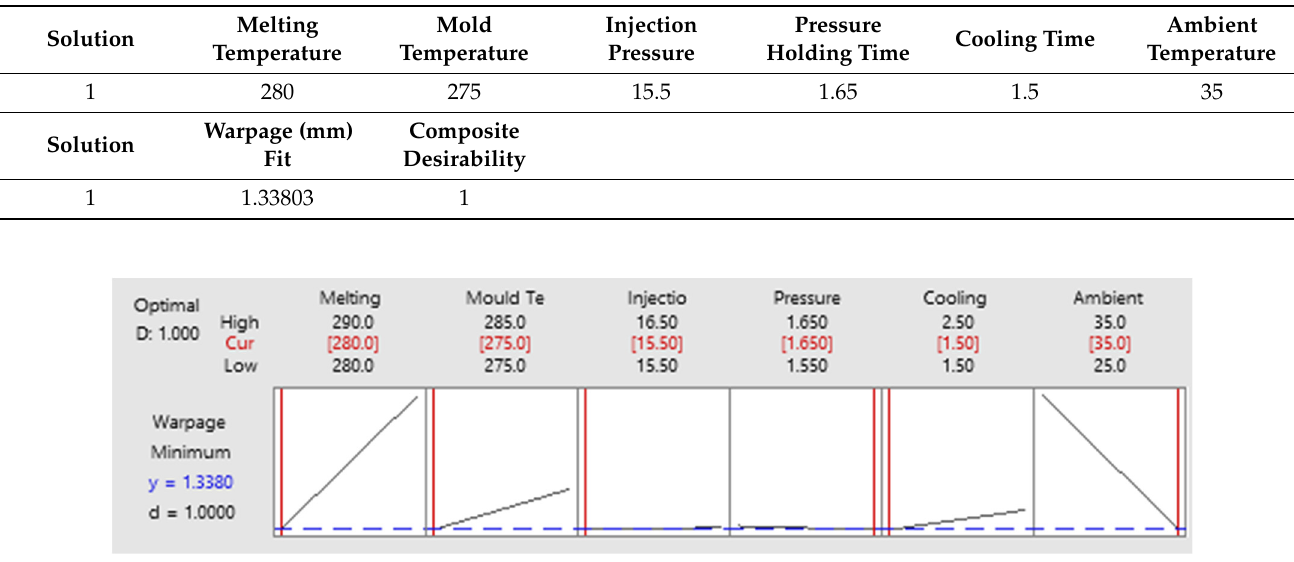
Figure 8. Graphical representation of the optimized solution .